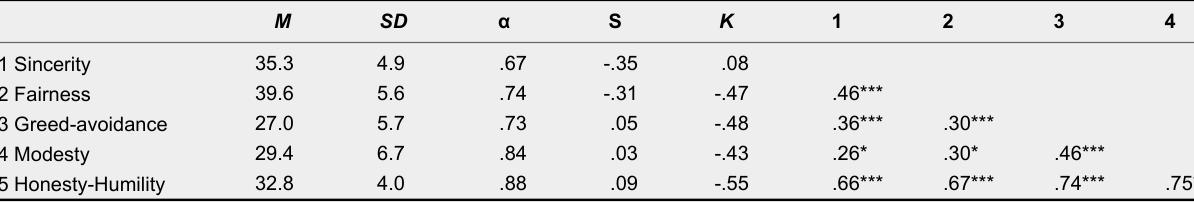
Descriptive Analysis of Honesty-Humility and its Facet